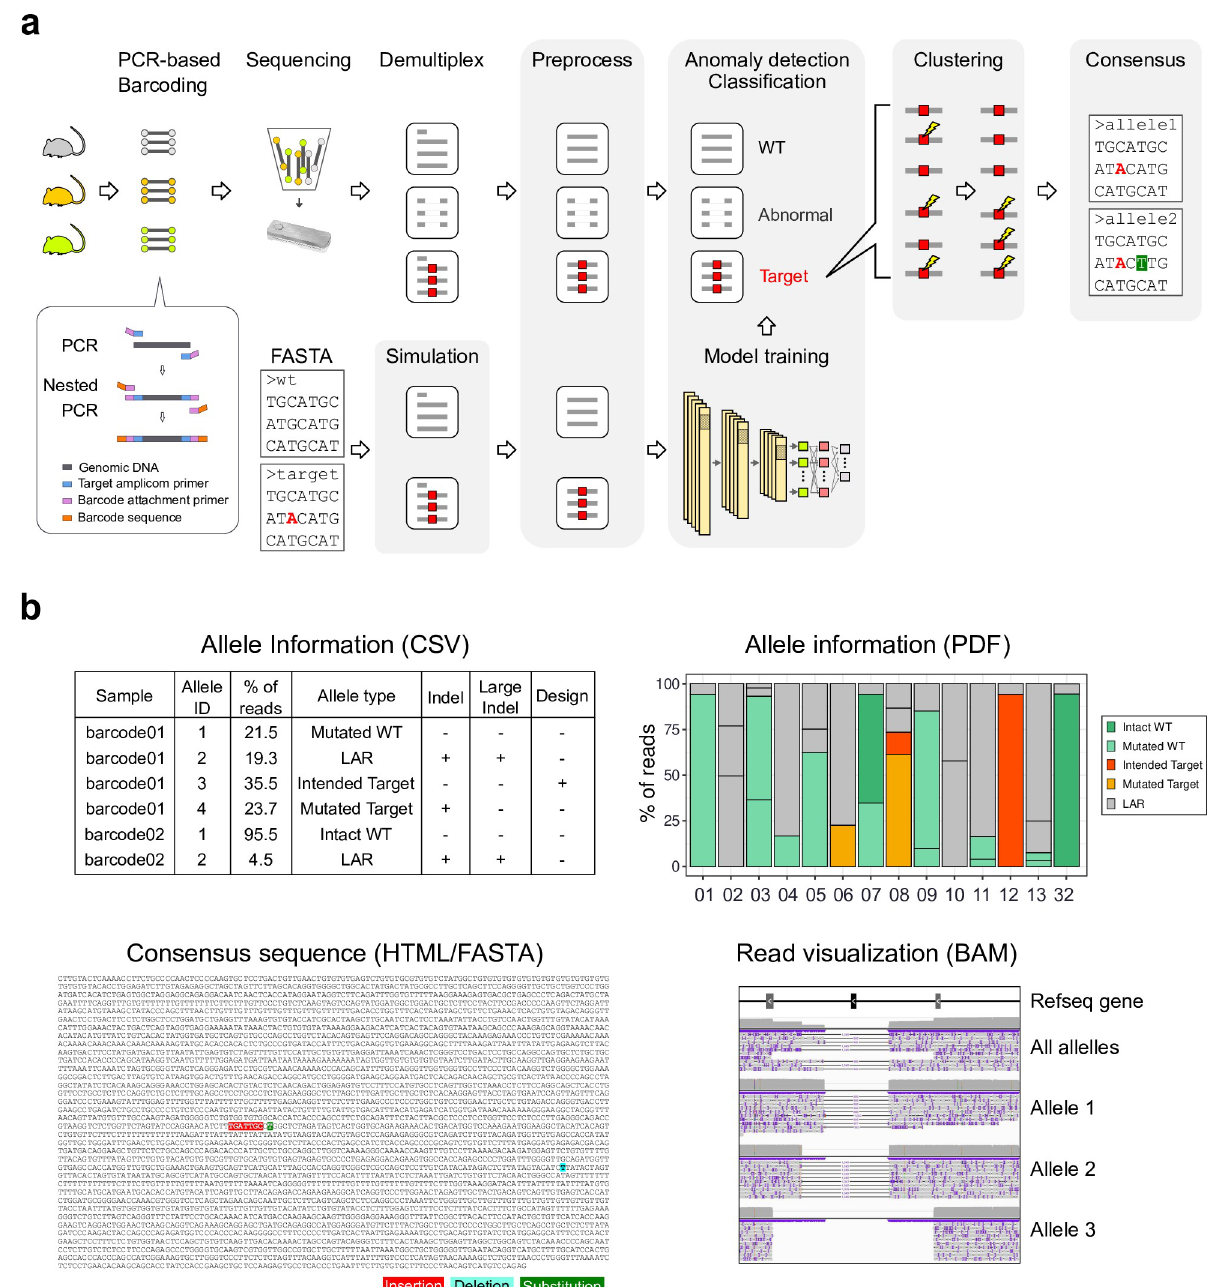
Fig 1. Overview of the methods. (a) The schematic of DAJIN’s workflow. DAJIN automates the procedures highlighted in grey. Red-coloured nucleotides represent intended PM. A green-highlighted nucleotide represents unintended substitution. Illustrations were modified from the Togo picture gallery, licenced under CC-BY 4.0 Togo picture gallery by the DBCLS, Japan. (b) The outputs of DAJIN. The file formats are described in parentheses. See S1 Data for raw data from https://osf.io/w7ade/. DAJIN AU : AbbreviationlistshavebeencompiledforthoseusedinFigs 1 (cid:0) 6 : Pleaseverifythatallentriesarecorrect : , Determine Allele mutations and Judge Intended genotype by Nanopore sequencer; DBCLS, Database Center for Life Science; LAR, large rearrangement; PM, point mutation; WT, wild